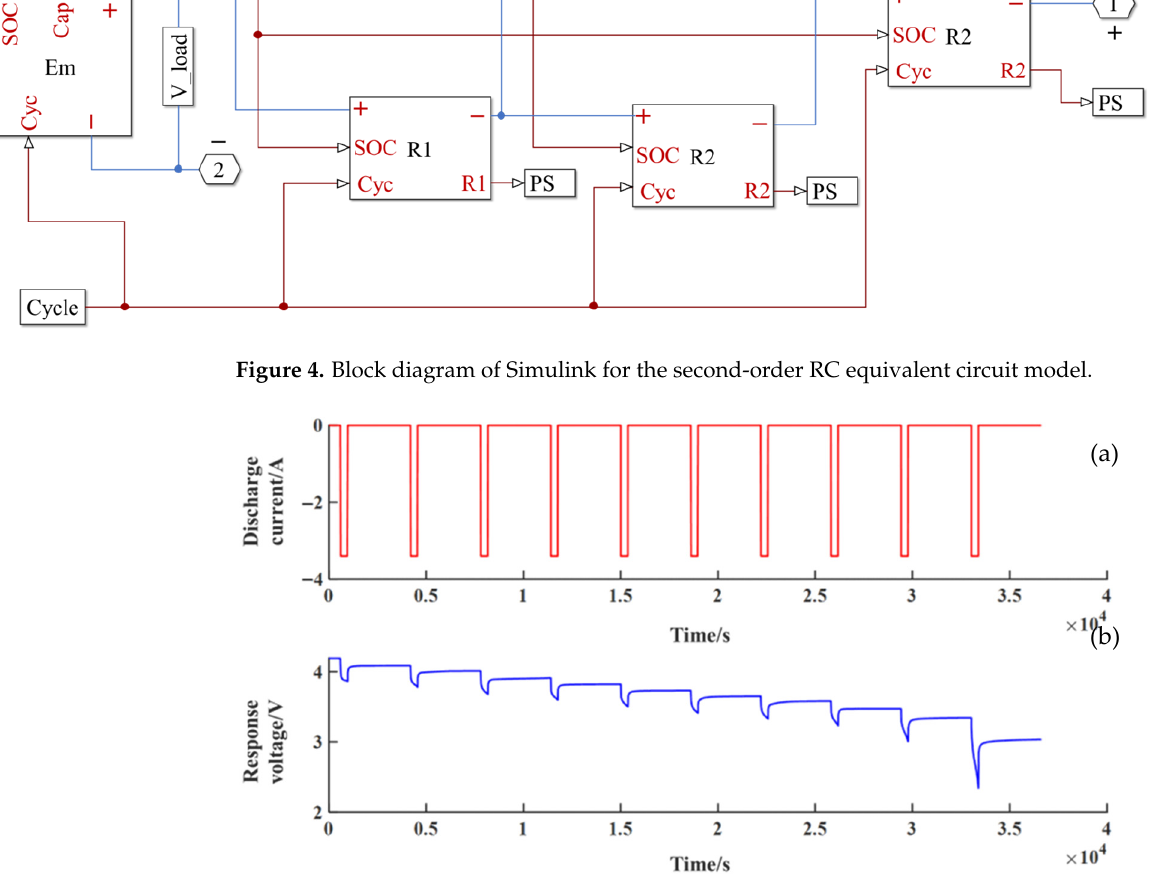
Figure 5. Response voltage curve from the Simulink simulation model: ( a ) the discharge current curve; ( b ) the response voltage curve.